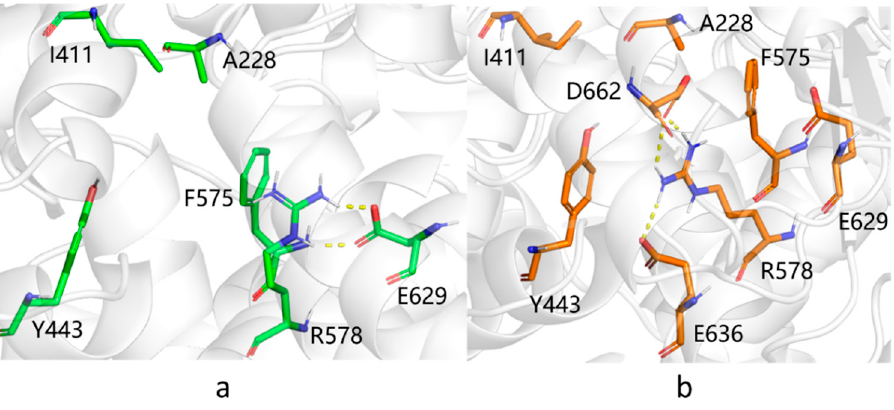
Figure 4. Salt bridges in the MCC950 binding pocket of ( a ) AF model 4 and ( b ) RF model 1. In addition to the hydrogen bonds formed between the amide group of MCC950 and the protein, the tricyclic head group of the small molecule also participated in hydropho- bic interactions with neighboring residues involving I411, Y443 and F575. In addition, the terminal carboxylate group engaged H-bonds with G629 (Figure 4a). We, therefore,